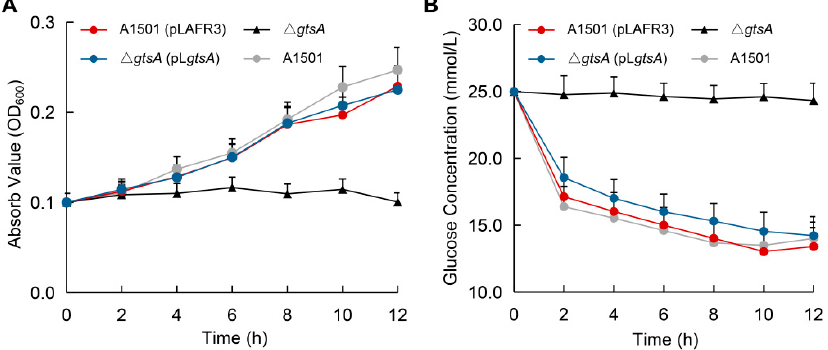
Figure 4. ( A ) Growth and ( B ) substrate consumption curves of the ∆ gtsA mutant strain in the glucose-sufficient medium (25 mmol/L).